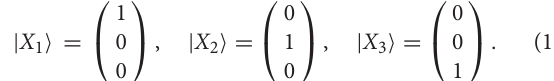
FIGURE 4 | An intuitive picture of a three-state analog of a longitudinal Stern-Gerlach interferometer. The interaction is controlled by position X 3 (the gray square). The free evolution performs an anticlockwise rotation. (A) At t 0 the system is prepared in a two-peaked superposition of center-of-mass = positions X 1 and X 2 , located outside of the interaction zone. (B) At t half of the wave packet is already in the interaction zone and emits a photon. t 2 the first half of the wave packet has already left the interaction (C) At t = region, but now the second half interacts with the field. In spite of its idealization, the picture correctly describes the structure of an exact quantum mechanical